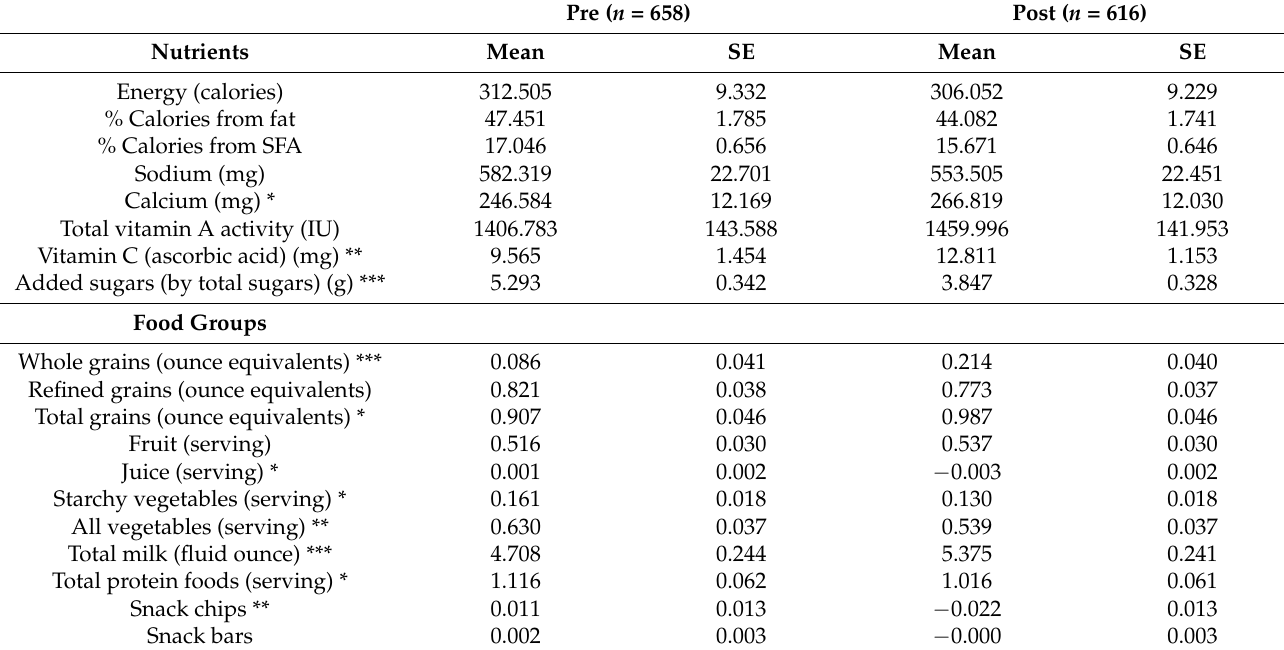
Table 3. Adjusted means of nutrients and food groups consumption at